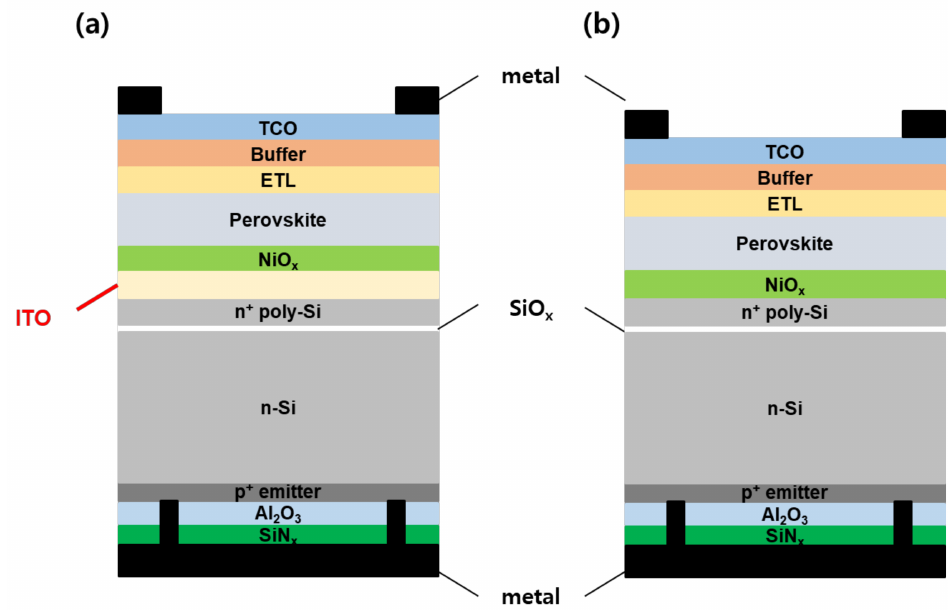
Figure 1. Schematic of 2-T perovskite/TOPCon tandem solar cell, where ( a ) indium tin oxide (ITO) and ( b ) NiO x /n + poly-Si direct